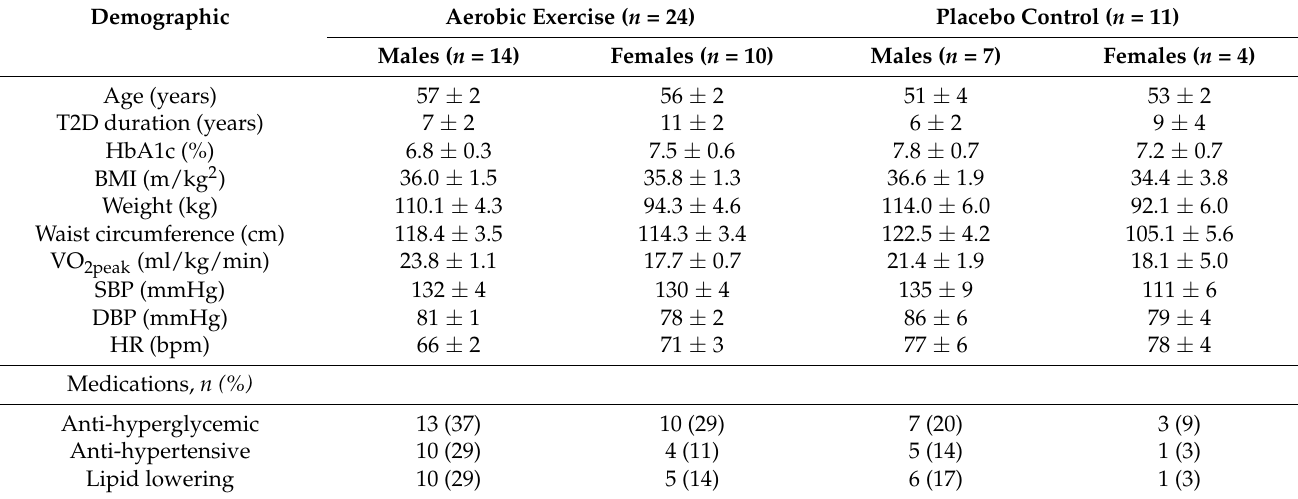
Figure 1. CONSORT flow diagram. Table 2. Baseline characteristics of participants.